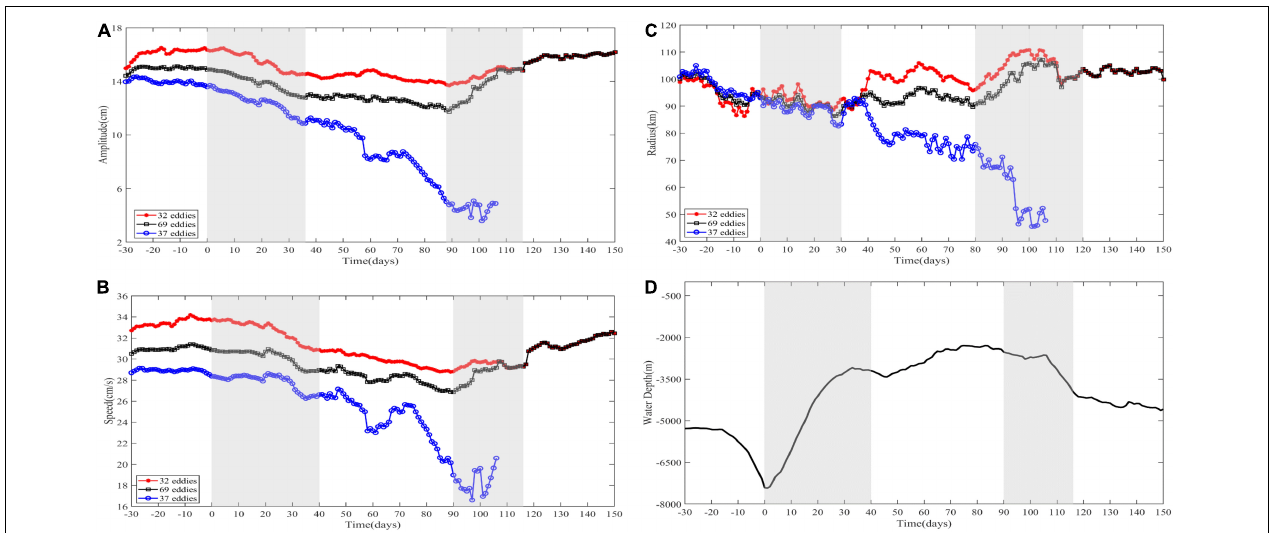
FIGURE 4 | Comparison of mesoscale eddy amplitude, rotation speed, radius with topography under conditions. (A) The mean curve of the amplitude for 69/32/37 mesoscale eddy trajectories. (B) The mean curve of the rotation speed for 69/32/37 mesoscale eddy trajectories. (C) The mean curve of the radius for 69/32/37 mesoscale eddy trajectories. (D) The mean curve of the topography for 69 mesoscale eddy trajectories (136 ◦ E–146 ◦ E, 20 ◦ N–35 ◦